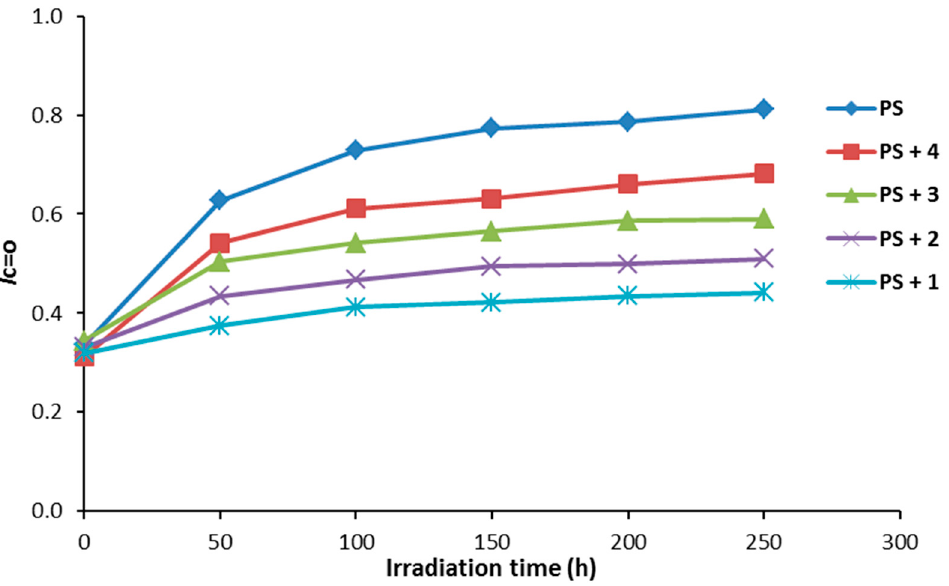
Figure 4. The effect of irradiation on the I CO index for PS films.